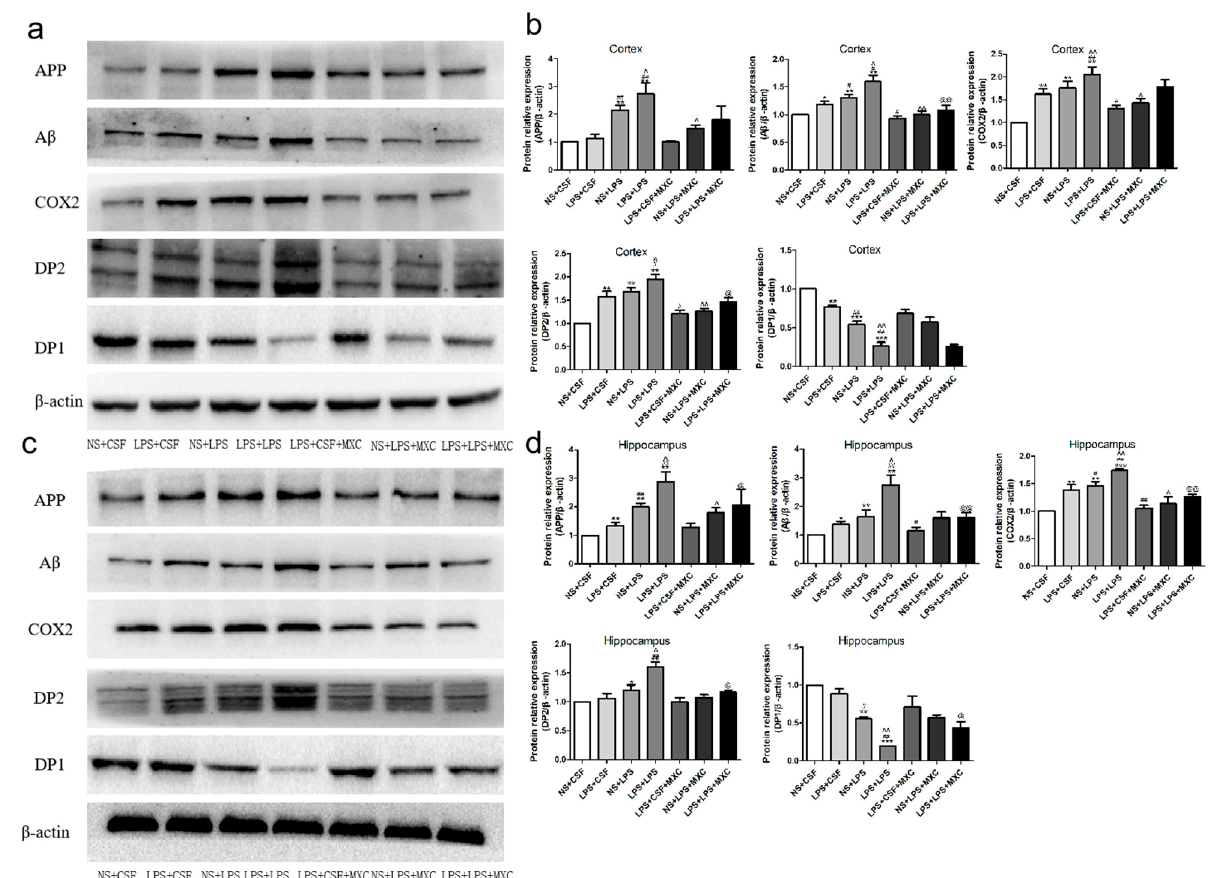
Figure 5. Western blot analysis of the relative protein contents in the cortex and hippocampus: ( a ) Western blot analysis of the relative protein contents in the cortex. ( b ) The expressions of APP, A β , COX-2, DP2, and DP1 were detected by Western blotting using specific antibodies in the cortex of rats. Protein contents were plotted for NS + CSF, LPS + CSF, NS + LPS, LPS + LPS, LPS + CSF + MXC, NS + LPS + MXC, and LPS + LPS + MXC. For APP, A β , COX-2, DP2, and DP1 proteins, the relative optical density was normalized to β -actin. Each result of the NS group is normalized to 1. ( c ) West- ern blot analysis of the relative protein contents in the hippocampus. ( d ) The expressions of APP, A β , COX-2, DP2, and DP1 were detected by Western blotting using specific antibodies in the hip- pocampus of rats. Protein contents were plotted for the NS + CSF, LPS + CSF, NS + LPS, LPS + LPS, LPS + CSF + MXC, NS + LPS + MXC, and LPS + LPS + MXC groups. For APP, A β , COX-2, DP2, and DP1 proteins, the relative optical density was normalized to β -actin. Each result of the NS group is normalized to 1. Data are mean ± SEM, n = 4. (* p < 0.05, ** p < 0.01, *** p < 0.001 vs. NS + CSF group; # p < 0.05, ## p < 0.01 vs. LPS + CSF group; ^ p < 0.05, ^^ p < 0.01 vs. NS + LPS group; @ p < 0.05, @@ p < 0.01 vs. LPS + LPS group).